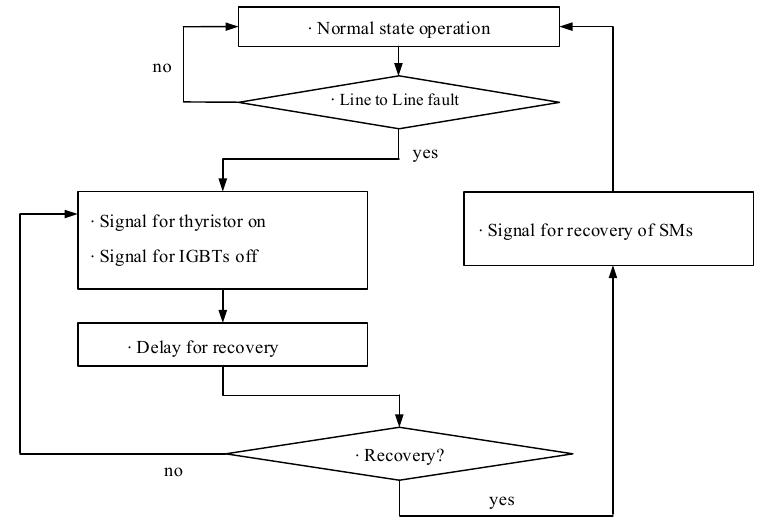
Figure 12. FRT strategy diagram for DC fault clearance.